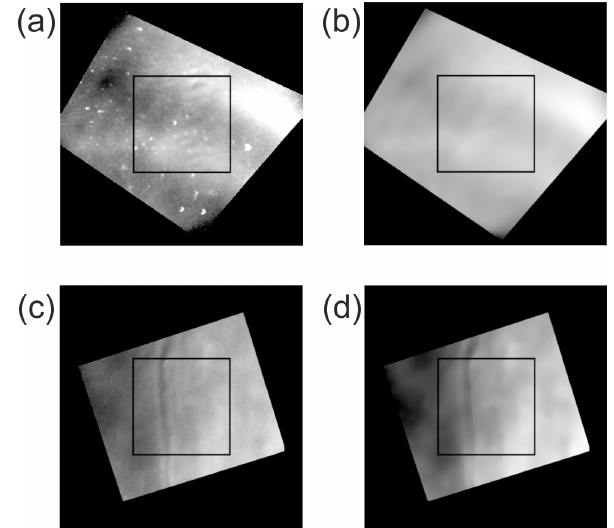
Figure 1. Images from the airborne FAIM during the first flight. The left column (a, c) shows two images which are flat fielded, contrast adjusted, un-warped (due to pitch, roll, and yaw angle), rotated to a northward position, and mirrored to fit the correct west–east posi- tion giving a satellite’s view of the airglow layer. The right column (b, d) shows the same images after applying the median blur. The image in the upper row (a, b) is an extreme example since the roll angle of − 27 ◦ is rather high, which results in a large image. For the analysis only absolute roll angles of 25 ◦ at maximum are used. This holds for the image shown in the second row (c, d) . The squares mark the regions of interest which are used for the calculation of the spectral analysis if roll and pitch angles fulfil the selection cri-